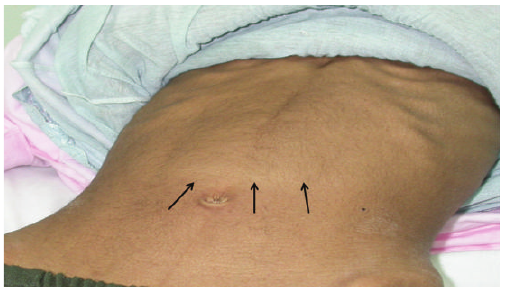
Figure 3: Ultrasound abdomen shows thickening of antral (aster- isks) and pyloric wall.